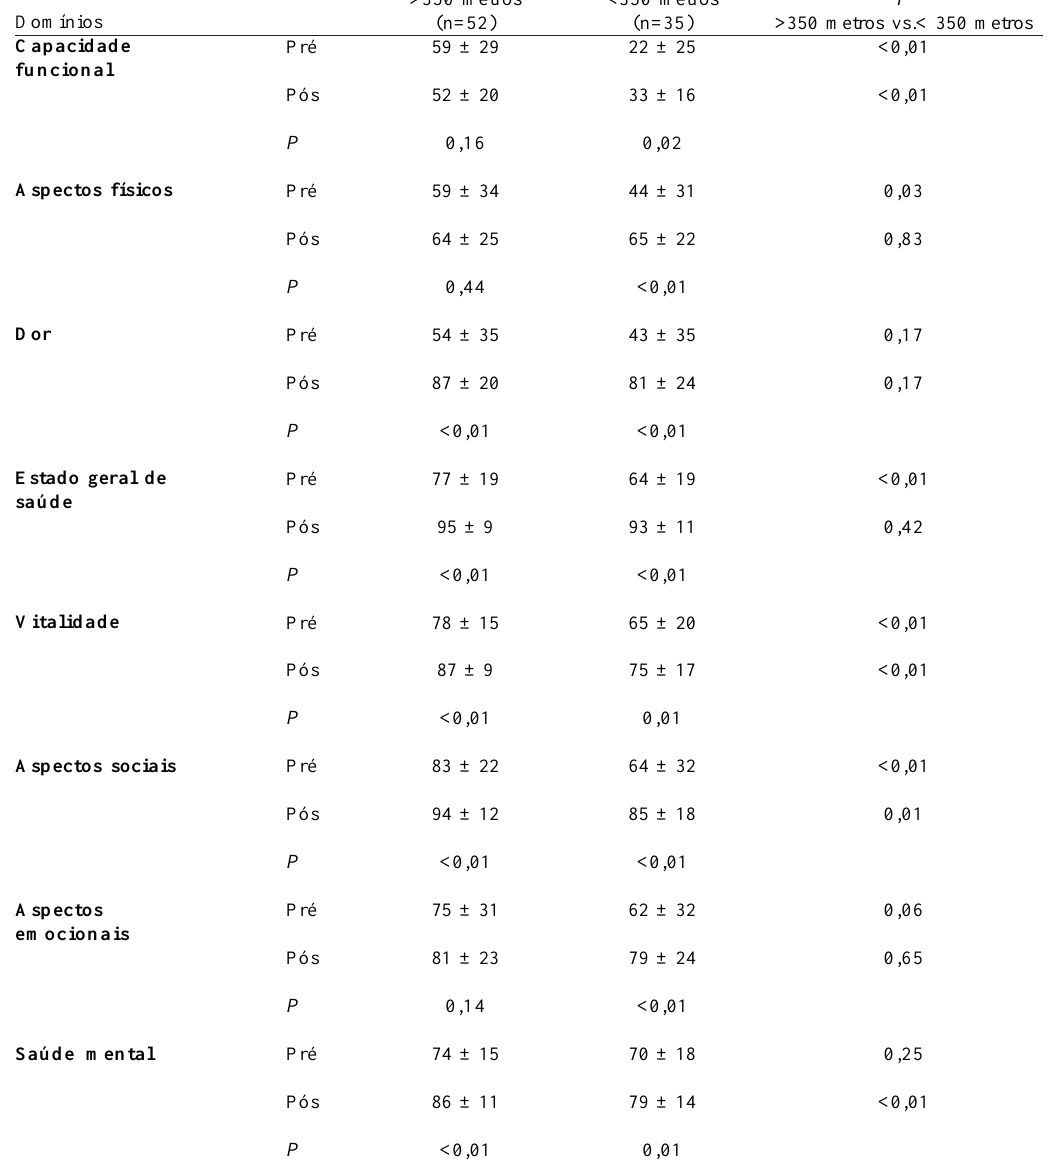
Tabela 6. Dados referentes ao questionário de qualidade de vida SF-36: comparação dos dados pré-operatório vs. pós-operatório em cada grupo e a diferença entre os